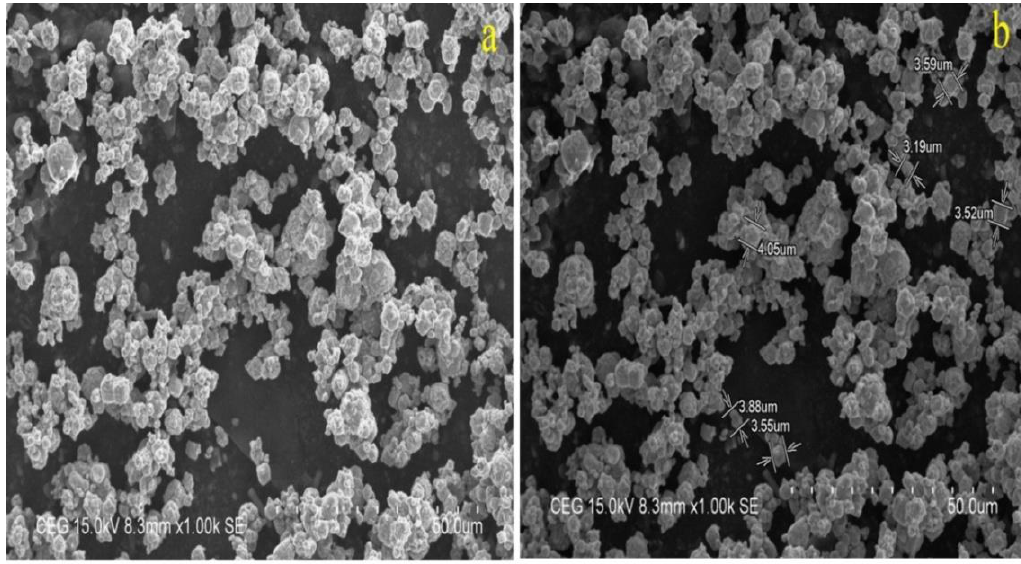
Figure 2. ( a ) Tungsten carbide SEM morphological image; ( b ) size of the reinforcement.